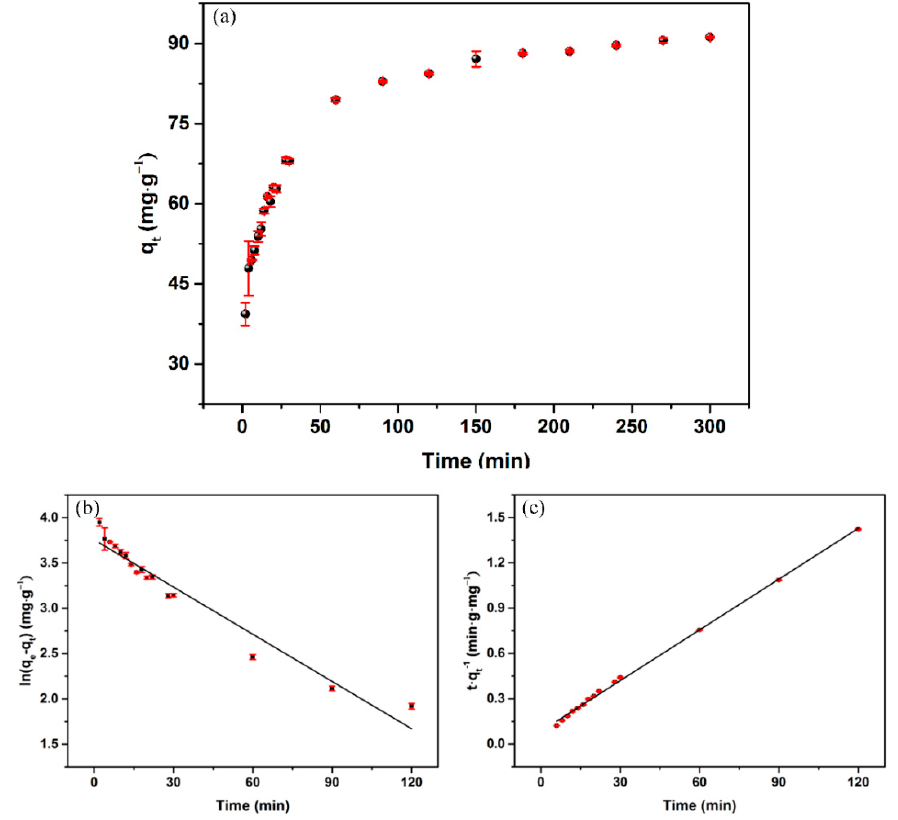
Figure 4. ( a ) Adsorption kinetics of HA / Fe 3 O 4 / OS, based on ( b ) the pseudo-first-order model and ( c ) the pseudo-second-order model (initial Hg(II) ion concentration, 25 mg · L − 1 , pH =